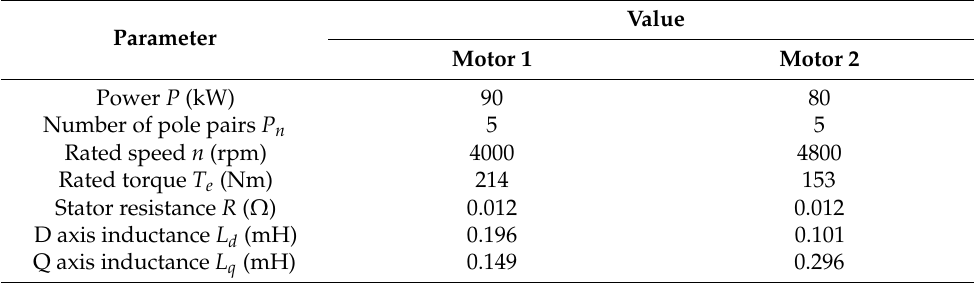
Table 1. Parameters of